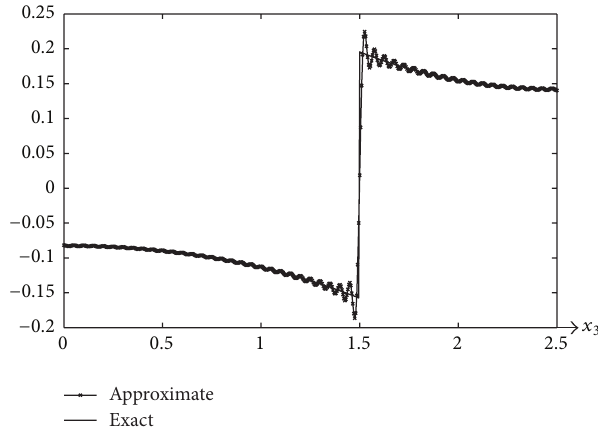
Figure 3: The graphs of ℎ 1 2 and ℎ 1,𝑁 2 for 𝑁 = 100 , 𝑥 0 1 = 2 , 𝑥 0 2 = 3 , and 𝑥 0 3 = 1.5 .